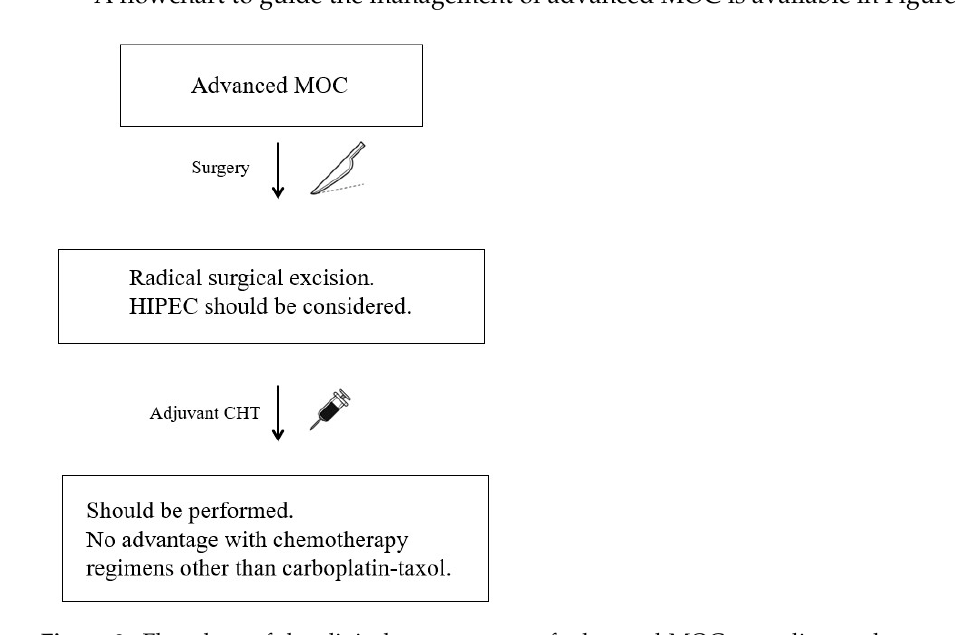
Figure 2. Flowchart of the clinical management of advanced MOC according to the most recent evidence (CHT: chemotherapy; HIPEC: hyperthermic intraperitoneal chemotherapy; MOC: mucinous ovarian cancer).